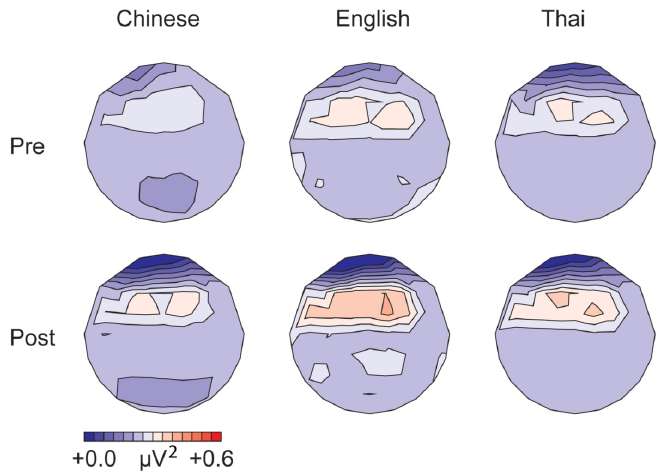
Figure 2. Mean spectral power in the gamma band (200–400 ms) for the three language groups, before ( pre , upper row) and after training ( post , bottom row), collapsed over tone and